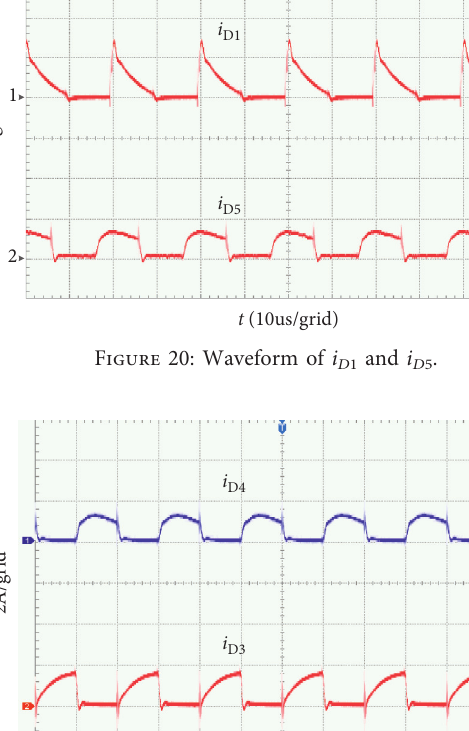
Figure 21: Waveform of i